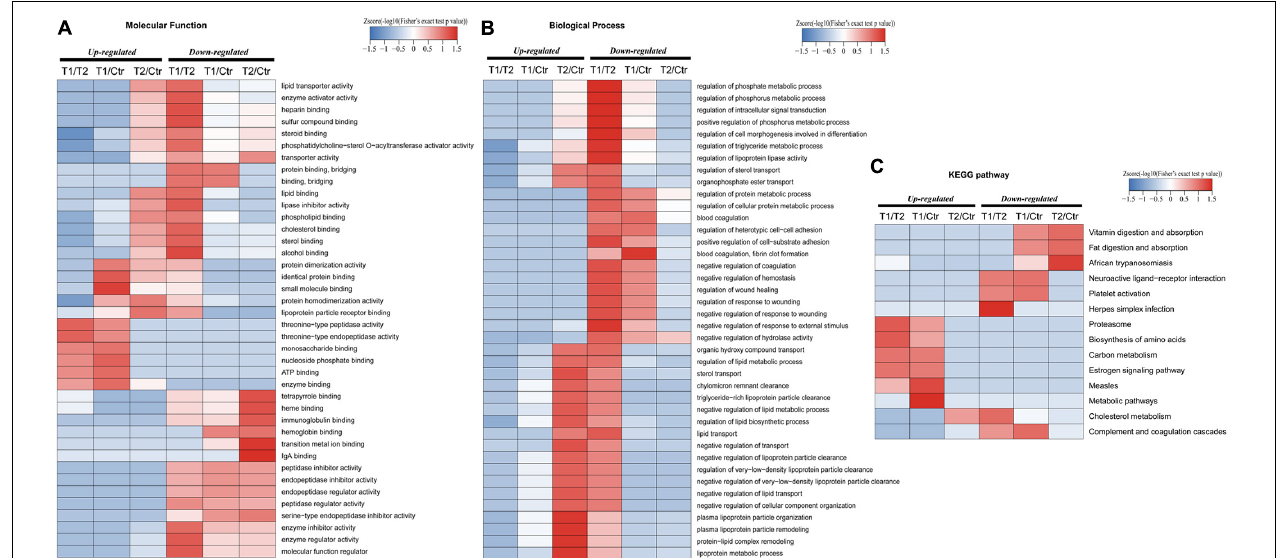
FIGURE 3 | Gene ontology (GO) and kyoto encyclopedia of genes and genomes (KEGG) pathway enrichment analysis of differentially expressed proteins. (A) Molecular function enrichment analysis of different proteins among the T1, T2, and control groups. (B) Biological process enrichment analysis of the detected differentially expressed proteins among the T1, T2, and control groups. (C) Top 14 enriched KEGG pathways are referenced among the T1, T2, and control groups.